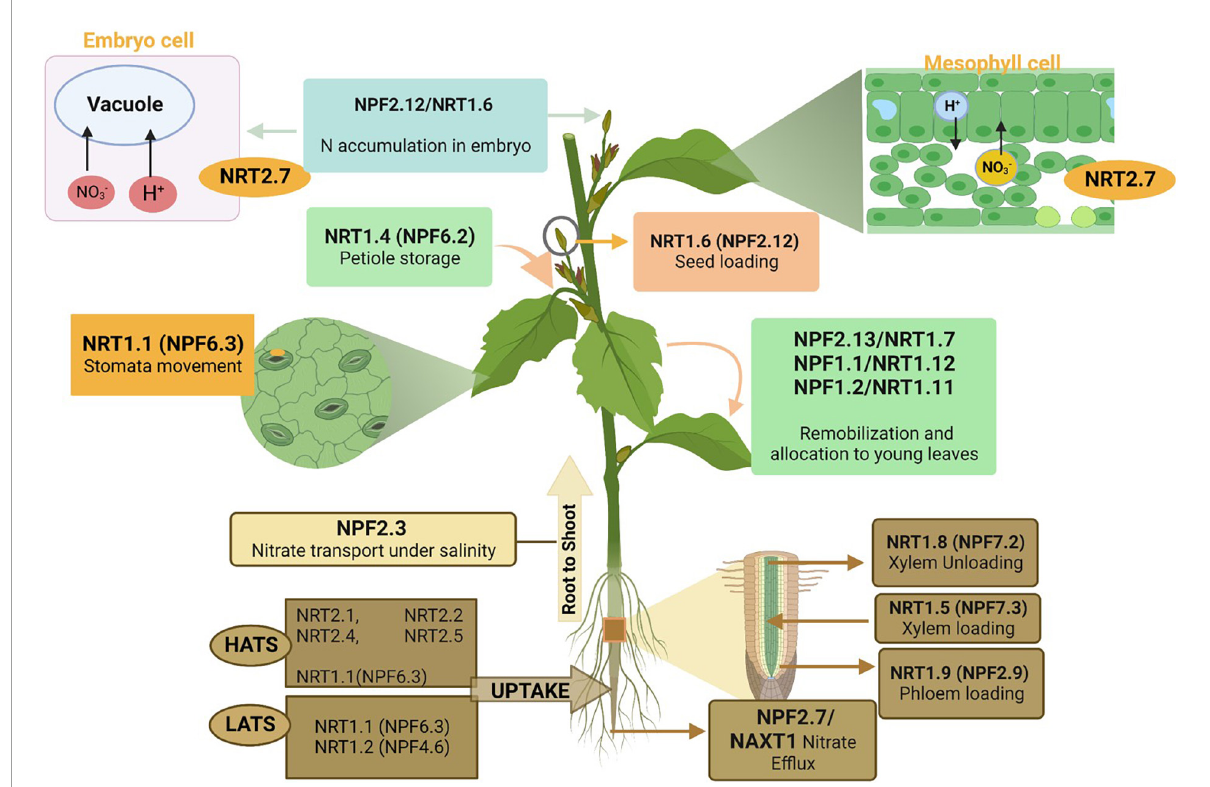
FIGURE4 Roles of different nitrogen transporters in nitrate uptake and efflux from the soil, transportation from roots to shoots, allocation and assimilation in plant leaves, and seed development. As mentioned in the above section, these nitrogen transporters are linked to different families. The figure created with Biorender